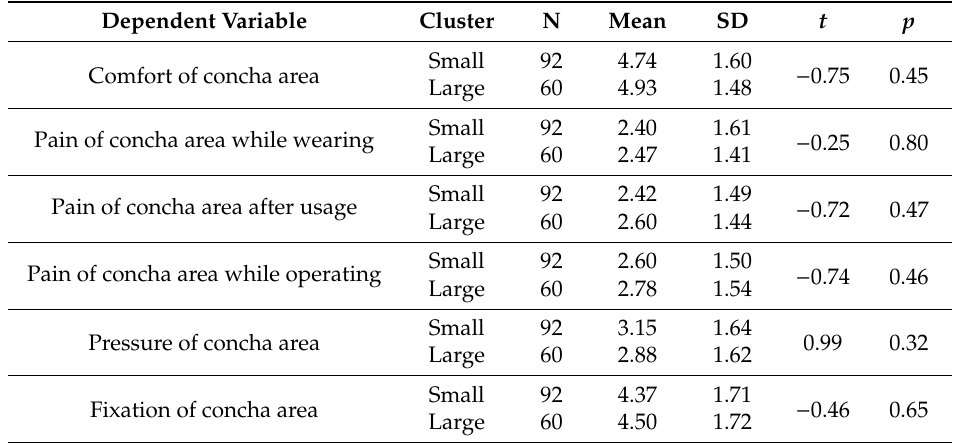
Table 8. Results of independent sample t -test for wearing comfort di ff erence according to concha length clusters.